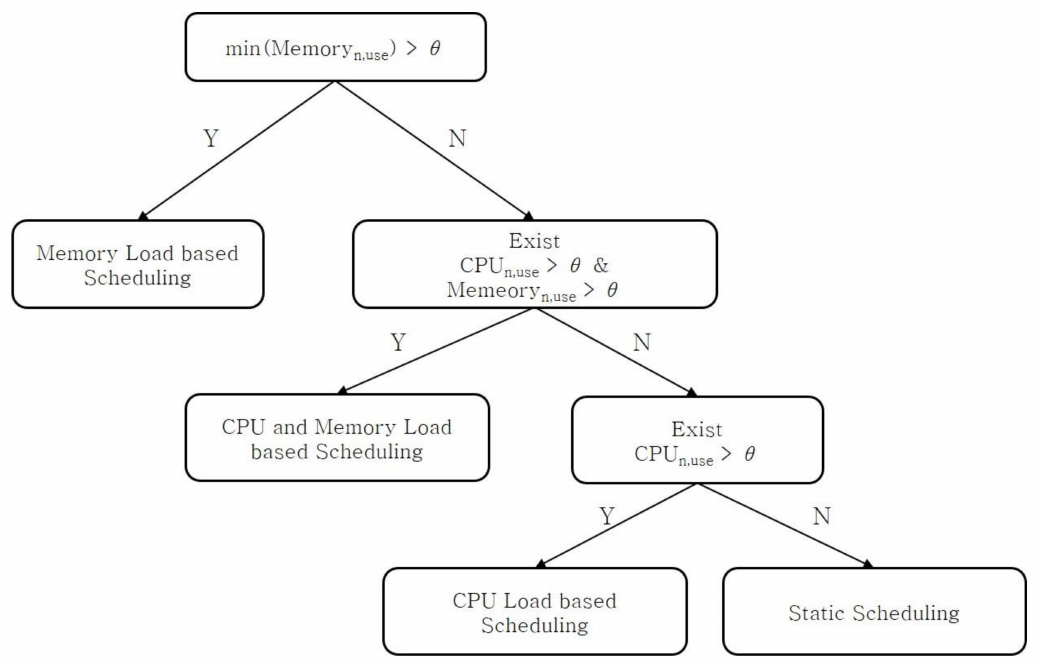
Figure 3. Task scheduling decision